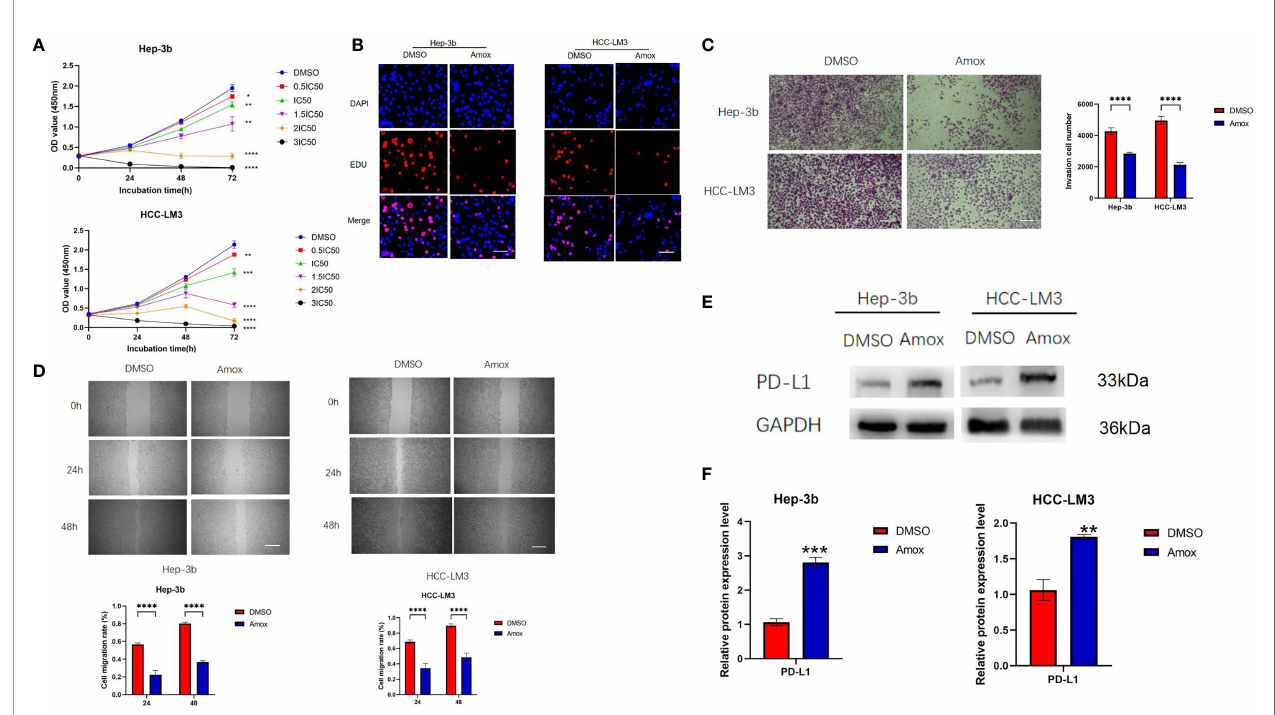
FIGURE 7 | Amoxapine decreased the proliferation, invasion, and migration of human HCC cells by inhibiting GUSB and upregulating PD-L1 expression in HCC. (A) The growth curves of cells were plotted after adding DMSO or amoxapine based on the CCK-8 assay. (B) EdU assay was performed to assess cell proliferation of HCC cells added with DMSO or amoxapine. Scar bar, 50 um. (C) Transwell invasion assay was performed to assess invasion of HCC cells added with DMSO or amoxapine. Scar bar, 100 um. (D) A Scratch assay was performed to assess the migration of HCC cells added with DMSO or amoxapine. Scar bar, 250 um. (E, F) The protein expression of PD- L1 in HCC cells was added with DMSO or amoxapine. Panel (E) represents the variation of protein bands, and Panel (F) illustrates the protein gray value analysis. Each experiment was repeated three times. * P < 0.05; ** P < 0.01; *** P < 0.001; **** P <